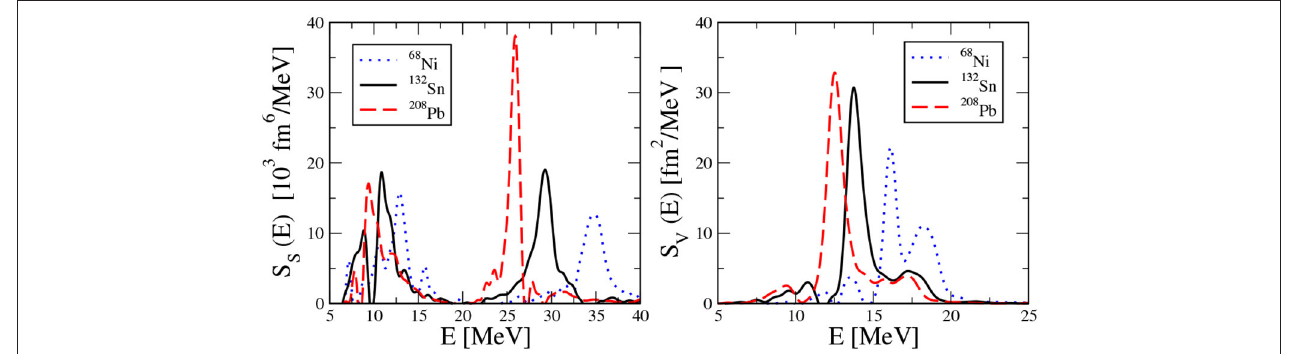
FIGURE 4 | (Color online) The strength function vs. excitation energy for the three nuclei under study with SAMi-J31 interaction. The left panel refers to the IS strength, the right panel to the IV strength. The curves are normalized to the Energy Weighted Sum Rule (EWSR) of the IS (left) or IV (right) strength of the system 132 Sn, respectively. Readapted from Zheng et al.